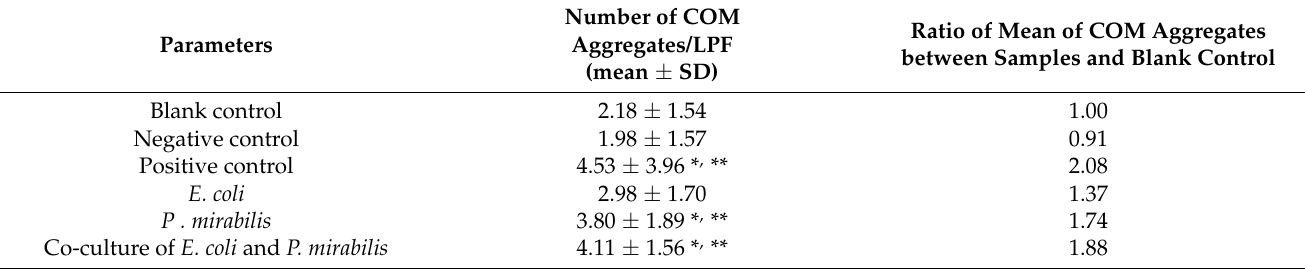
Table 3. Effect of bacteria on COM aggregates under microaerobic conditions.